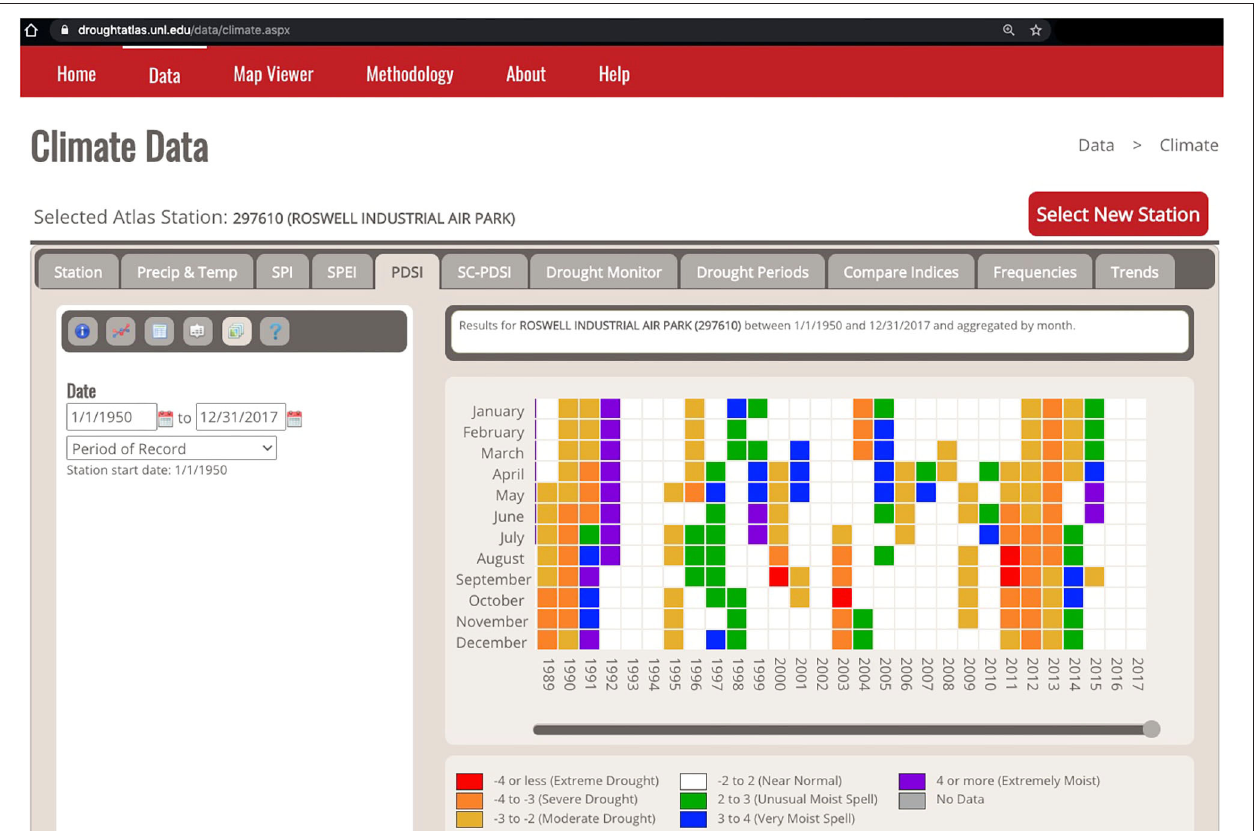
FIGURE 3 | An example of the Drought Risk Atlas [http://droughtatlas.unl.edu/data/climate.aspx] that highlights the monthly PDSI heat map of PDSI values for Roswell, NM, from 1988 to